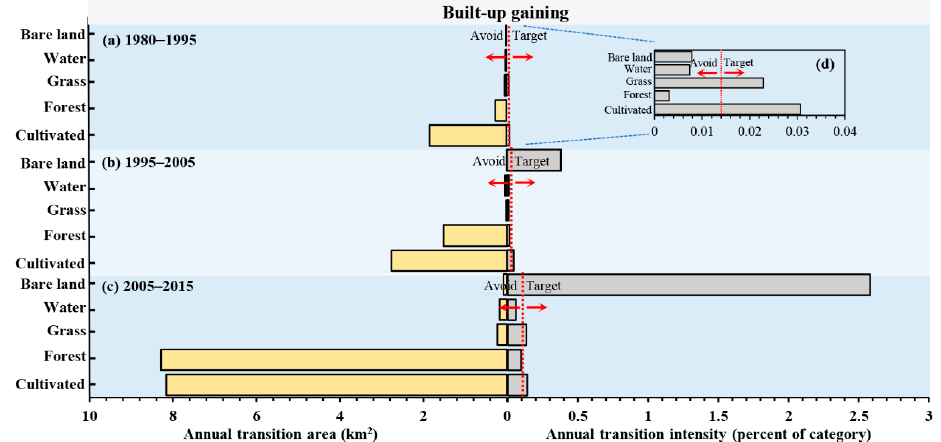
Figure 6. Annual size and intensity by category at three intervals.